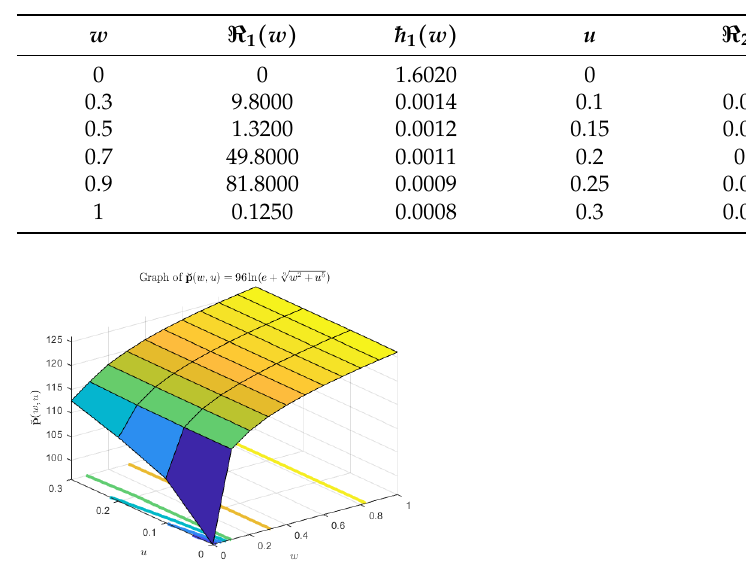
Table 2. Numerical resualts for some functions in Example 2.